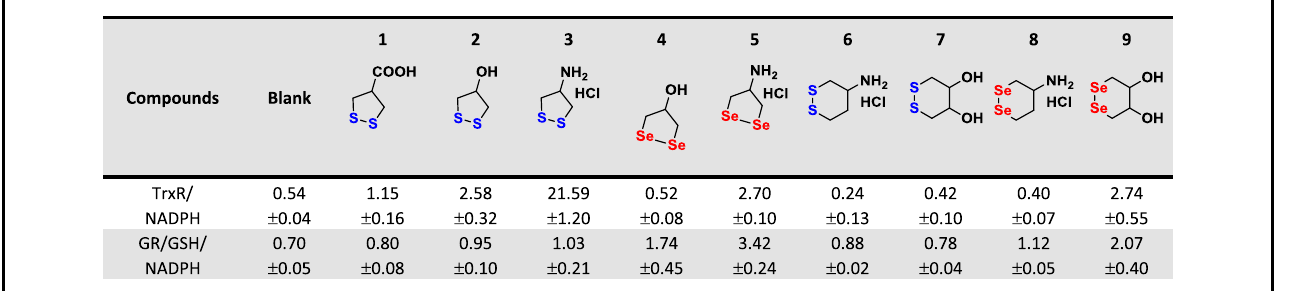
a The assays were performed by incubating the compounds (100 μ M) with the recombinant rat TrxR/NADPH (50nM and 200 μ M) or GSH (1mM), GR/NADPH (0.5 U mL − 1 and 200 μ M) in TE buffer for 10min at 37°C. The rates of NADPH decay were calculated based on the change of A 340 within the initial 3min. The data were expressed as mean±standard deviation (SD, n = 3). Source data are provided as a Source Data fi